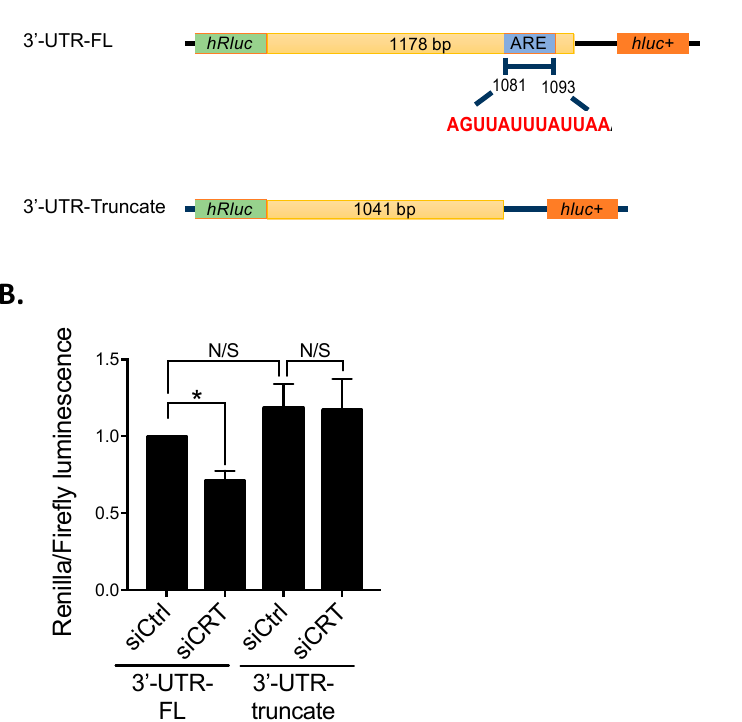
Figure 2. CRT stabilizes β 1-integrin mRNA stability via AU-rich element (ARE) at 3 ′ -untranslated region (3 ′ -UTR) ( A ) Schematic diagram of psiCheck2 reporter plasmid contains firefly (hluc+) and renilla luciferase (hRluc) genes were constructed with full-length (FL) or truncated 3 ′ UTR of β 1- integrin. According to ARE online database, the sequence of ARE at 3 ′ -UTR of β 1-integrin are clas- sified in the cluster 4. The predicted sequences are shown in red. CDS, coding sequence. ( B ) Cells were transfected with siCRT and siCtrl siRNA for 24 h, followed by transfecting with reporter plas- mids for 48 h. Cotransfected cells were lysed, and cell lysates were conducted to the reporter lucif- erase assay. Each bar in the histogram represents the ratio of renilla luminescence to the firefly lu- minescence. Results are shown as mean ± SD. All the experiments were repeated at least three times. * p < 0.05.